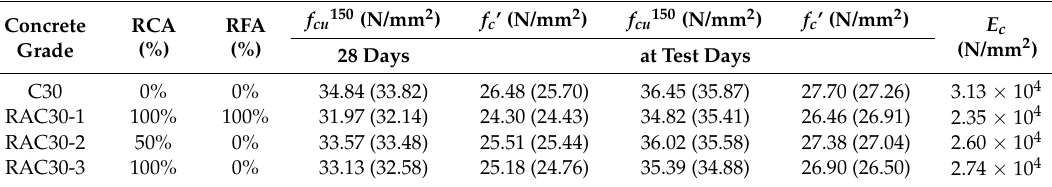
Table 3. Mechanical properties of concrete.